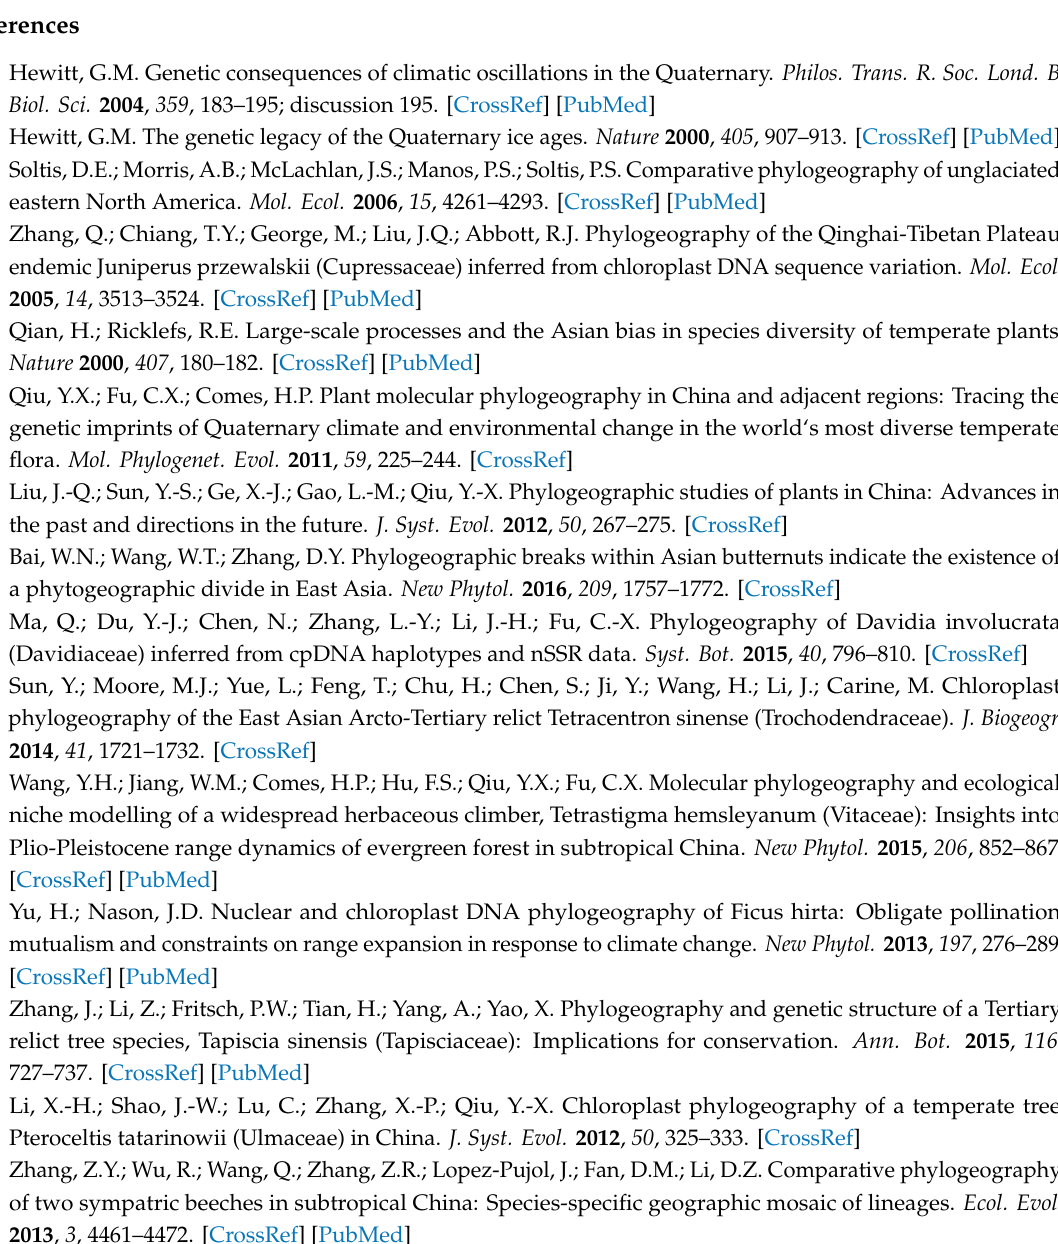
Table S1: List of 145 present records of L. chinense . Table S2: List of 21 environment variables used in this study. Figure S1: Haplotype networks of cpDNA, nrDNA, and six nuclear genes ( LcDHN-like , LcDHN-like1 , LcDHN-like2 , LtNCED1 , LtNCED3 and Ltosmotin-like ) in L. chinense